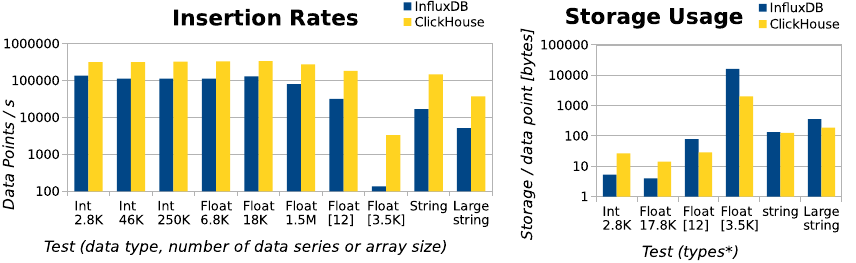
Figure 7. The comparison of InfluxDB and ClickHouse data insertion rates and storage